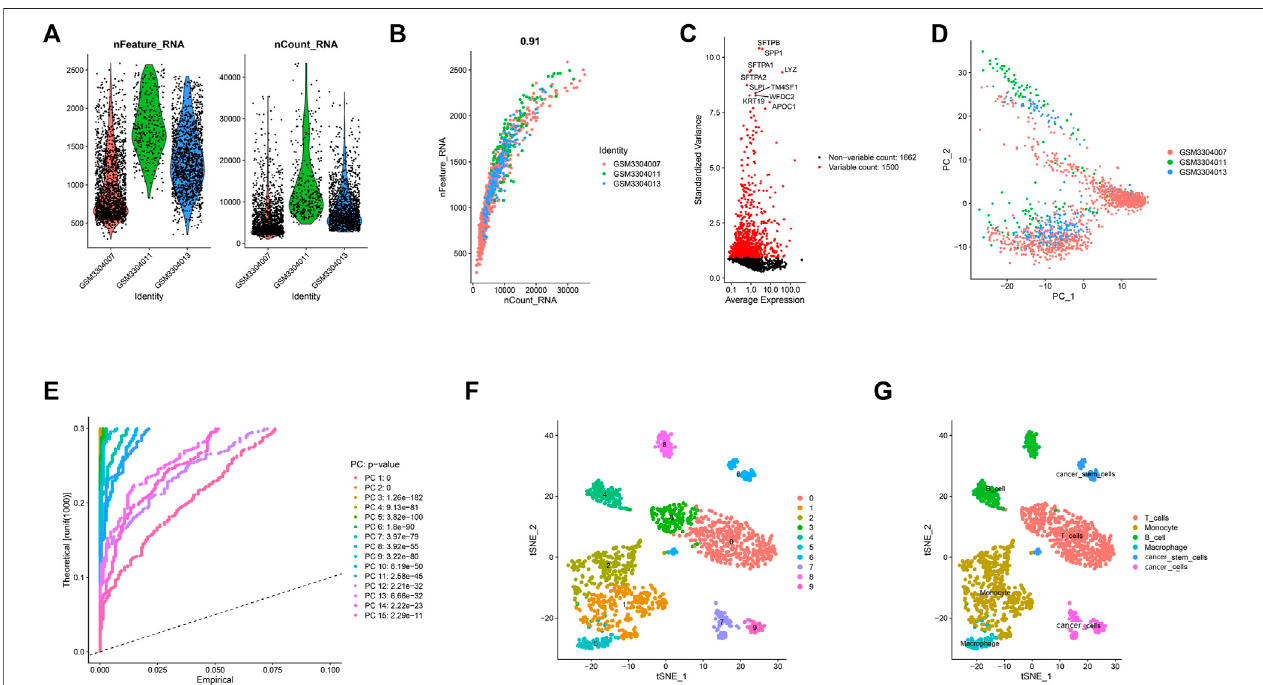
FIGURE1| 10cellclusterswereidenti fi edandannotatedbasedonmarkergenes. (A) AfterqualitycontrolofthescRNA-seqdata,3,583cellsfromthetumorcores of three human LUAD samples were included in the analysis. (B) Correlation analysis between sequencing depth and detected genes was examined, and the Pearson correlation coef fi cient was 0.91. (C) The variance of 3,162 genes were analyzed, the results indicated that 1,500 genes marked with the red dots had high variation and 1,662 genes marked with the black dots had low variation. (D) PCA showed no signi fi cant separations of cells in LUAD. (E) PCA determined 15 PCs with an estimated p value < 0.01. (F) Accordingtot-SNEalgorithm,1695LUADcellsweresuccessfullyaggregatedinto10clusters. (G) Basedonthemarkergenes,10clusters were annotated by the singleR.